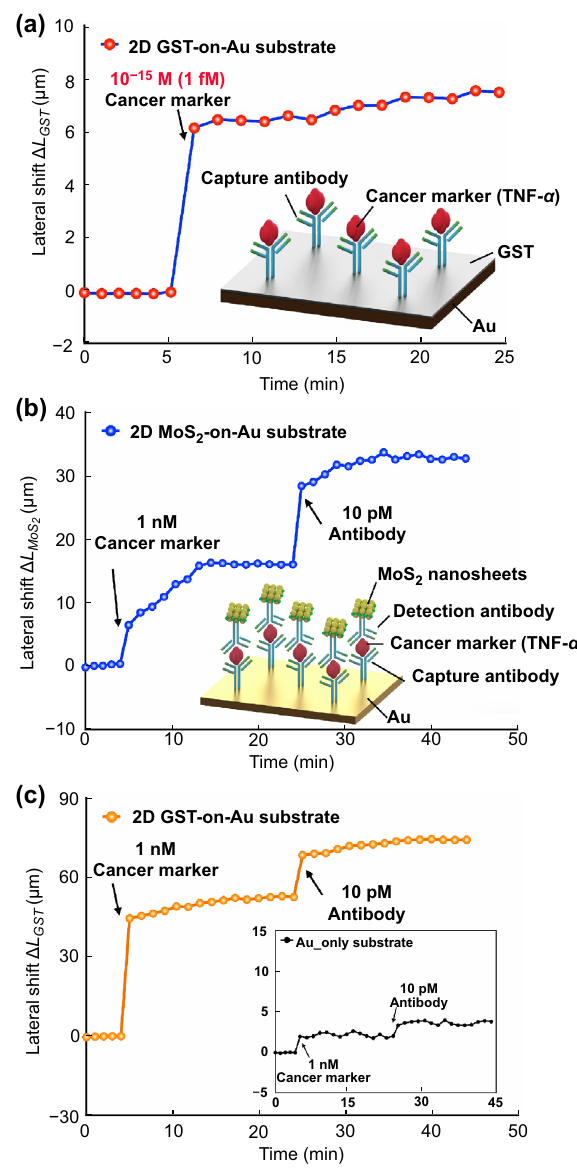
Fig. 3 a Detection of extremely low (1 fM) cancer marker concen‑ tration using 2D GST‑on‑Au substrate. b Detection of 1nм cancer marker using 2D MoS 2 ‑on‑Au substrate. c Detection of 1nм cancer marker using 2D GST‑on‑Au substrate with insert figure showing the performance of Au‑only